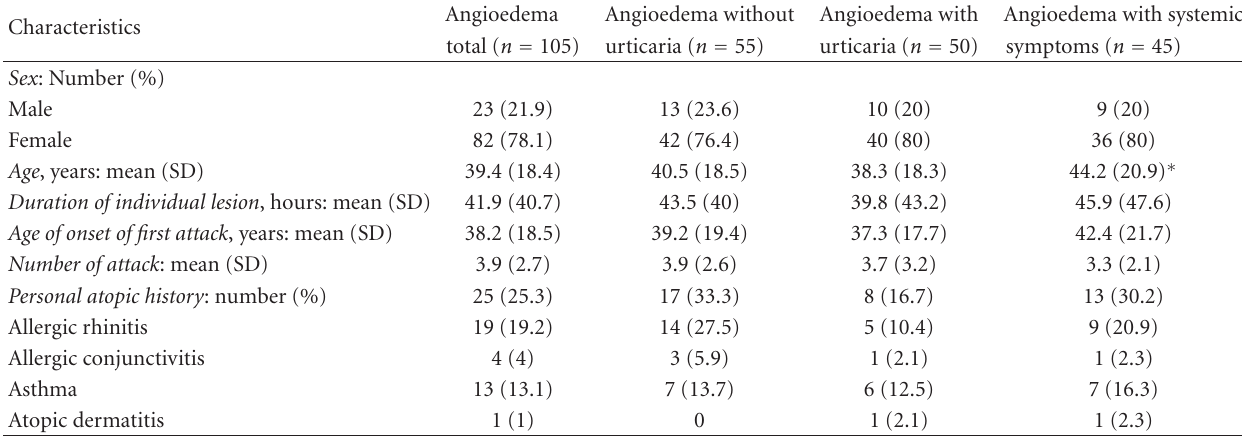
Table 1: Demographic data in various group of angioedema.